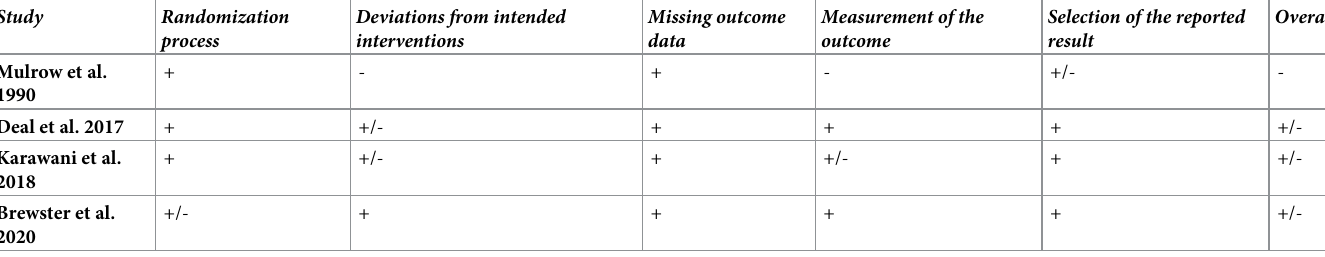
Table 2. Cochrane risk of bias tool for randomized trials.